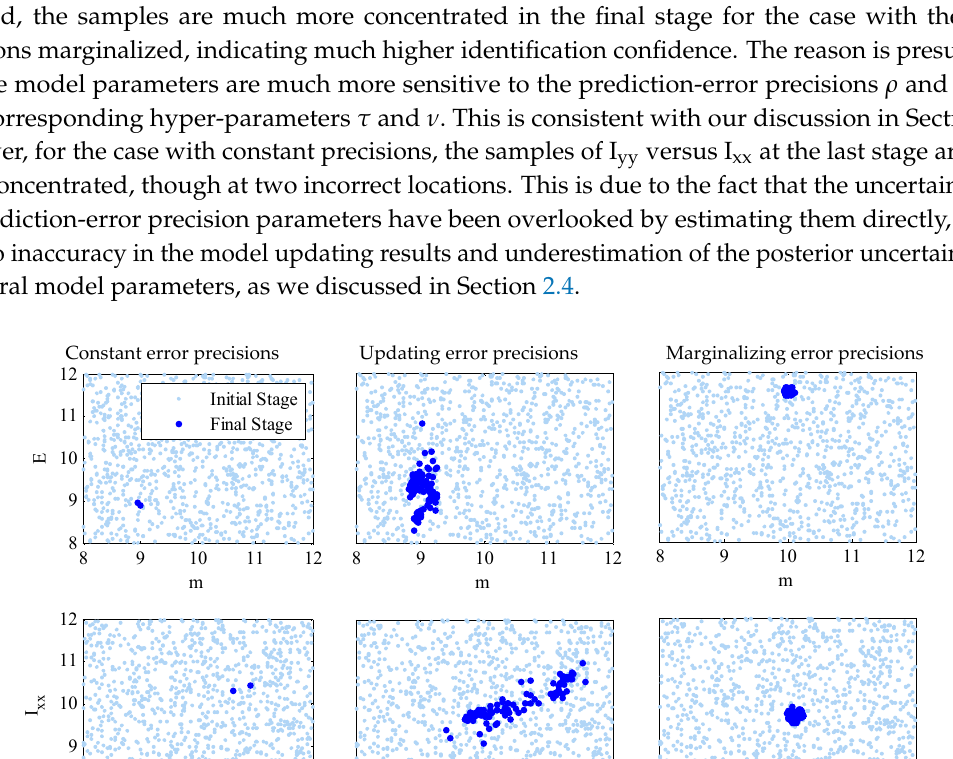
Table 2. Disturbance coefficients for structural model parameter components to introduce modeling uncertainties in model class ℳ (cid:2870) .